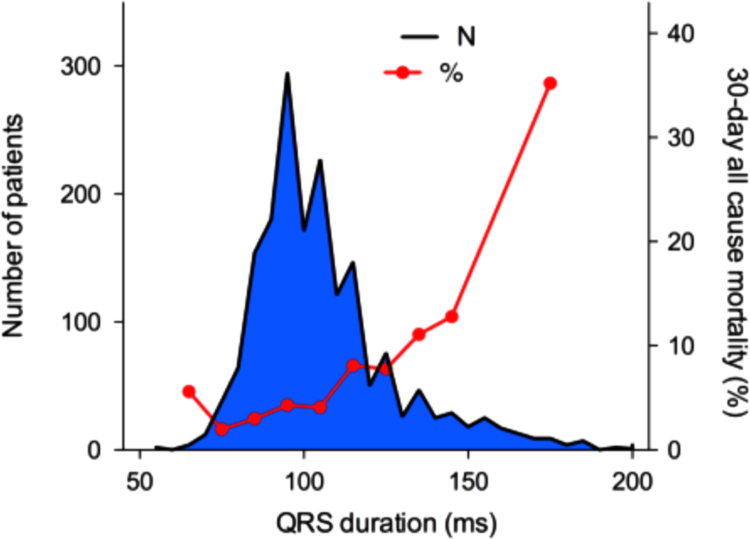
Histogram of number of patients, according to automatically measurement of QRS duration on prehospital ECG. Red line represents 30-day all-cause mortality according to QRS duration.